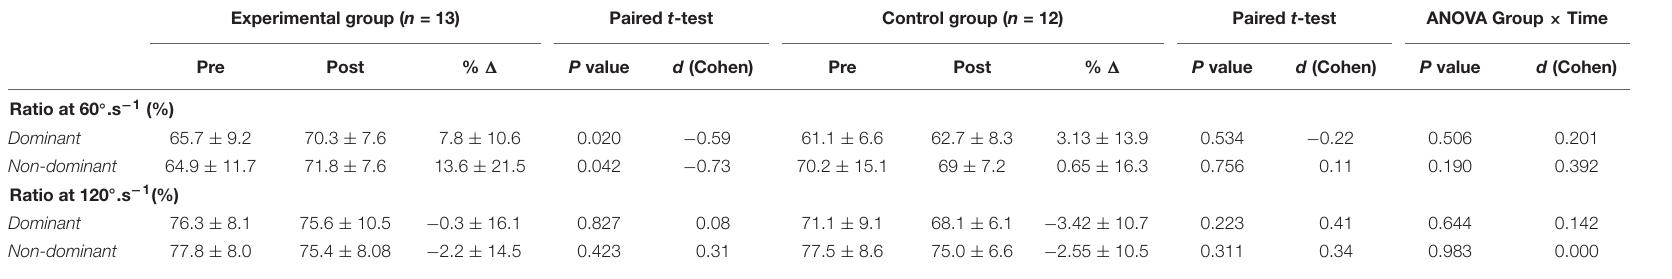
TABLE 6 | Hamstrings to quadriceps strength ratio